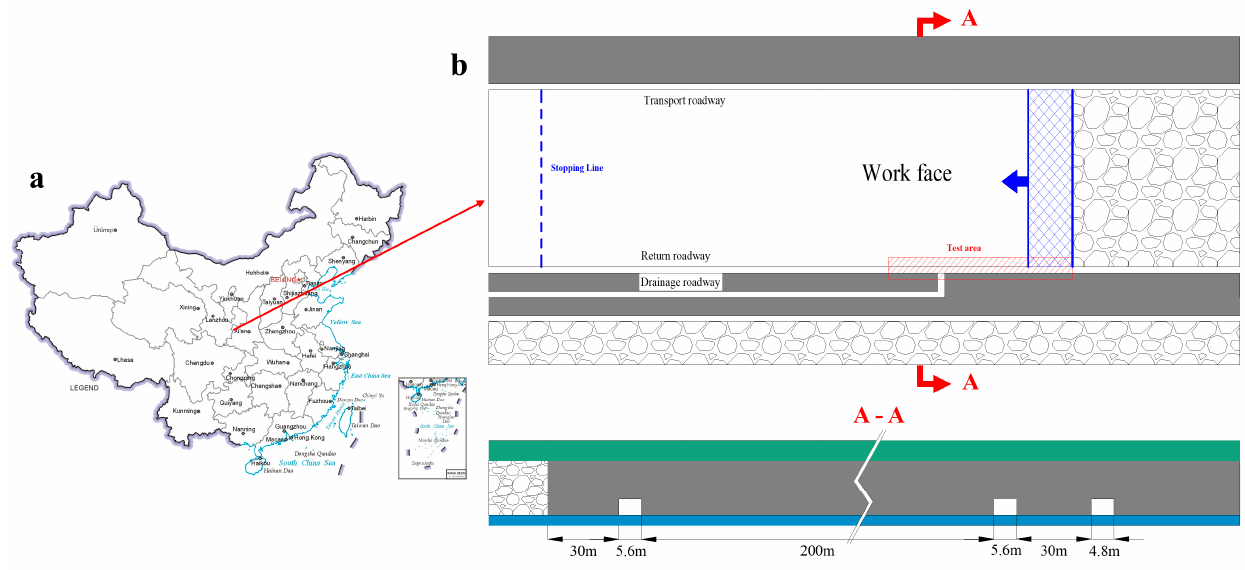
Figure 1. Mine location and working face layout. ( a ) Location of test site, ( b ) working face layout and cross section of test site.